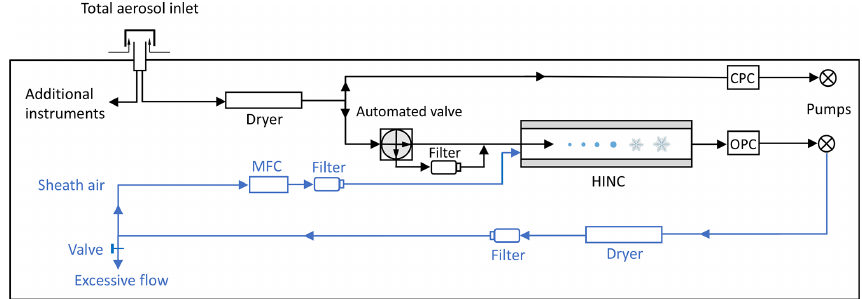
Figure 2. Flow diagram of HINC as setup inside the container during field measurements in Ny-Ålesund (figure adapted from Lacher et al., 2017). The blue part indicates modifications from Lacher et al. (2017) to adapt the recirculation of sheath air. MFC, CPC, and OPC represent the mass flow controller, condensation particle counter, and optical particle counter, respectively.